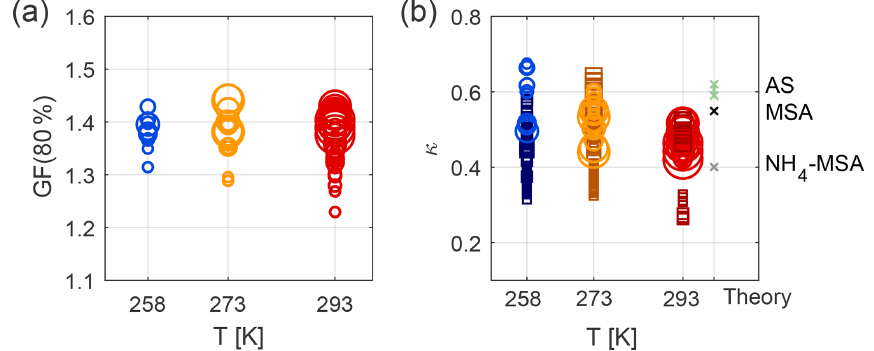
Figure 4. Temperature dependence of water uptake: (a) GF (80%), as measured from nano- and long-HTDMA (spheres), (b) κ values, as measured from nano- and long-HTDMA (spheres) and CCNc (squares). The size of the markers is related to the dry particle size selected, i.e. smaller markers describe results for smaller particles and vice versa. Results describe Exp. 2–5 and 8–11 at high humidity conditions. The theoretical κ values are taken from Fossum et al. (2018) for MSA and NH 4 MSA for 80nm dry particles and from the UManSysProp model for ammonium sulfate (AS), as found for 80nm dry particles, as recalculated from sub- and supersaturated water vapour conditions. Table 2. Mean κ values and their standard deviations (1SD), as calculated from nano- and long-HTDMA. Exp.